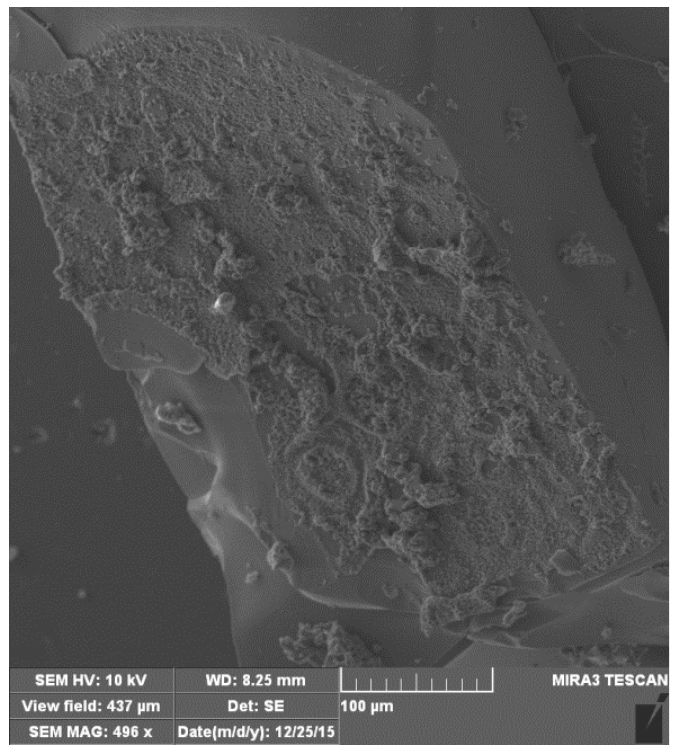
Figure 6. FESEM image of glass fiber–epoxy–glass capillaries composite.